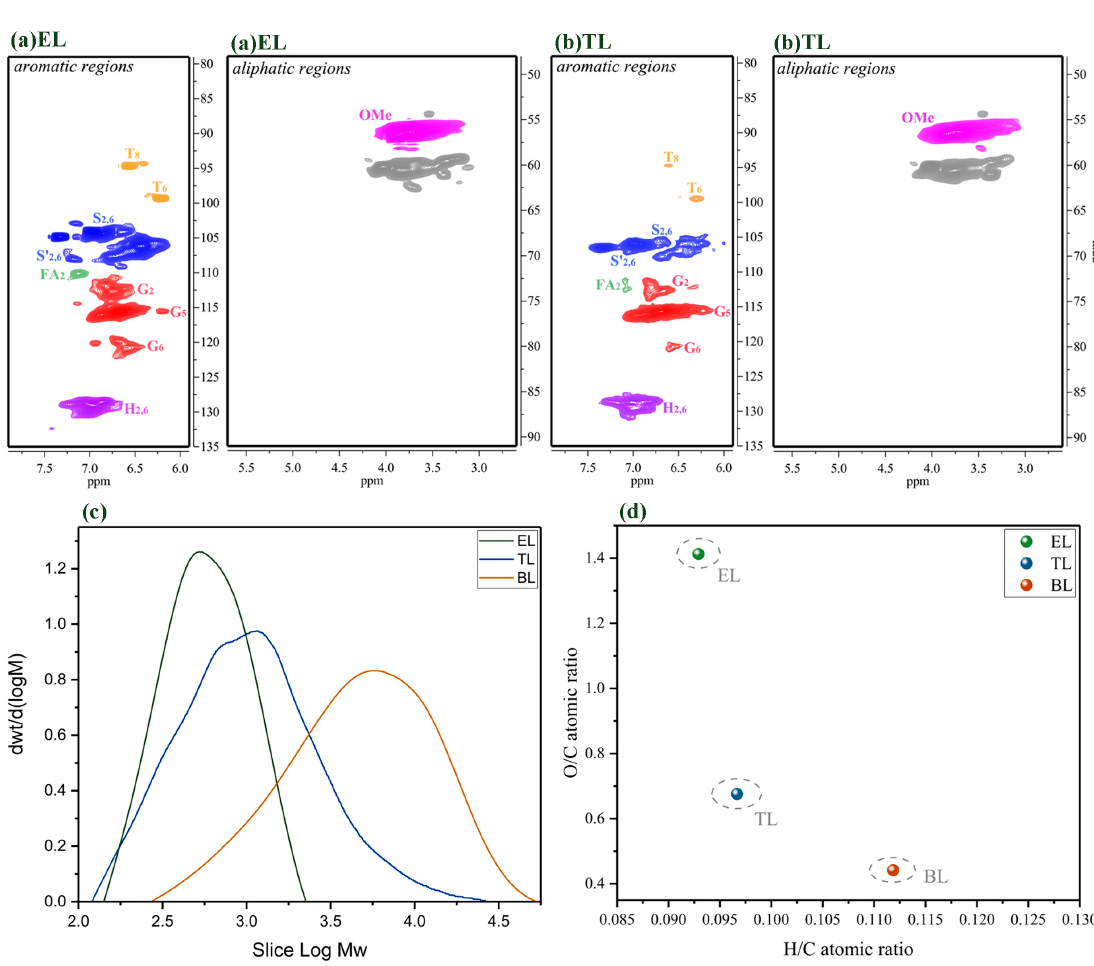
Figure 8. The 2D-HSQC NMR spectra, GPC, and elemental analysis of the residual lignin at 250 °C for 6 h. ( a ) The 2D-HSQC NMR spectra of the ethanol-soluble (EL) residue at 250 °C for 6 h; ( b ) the 2D-HSQC NMR spectra of the THF-soluble (TL) residue at 250 °C for 6 h; ( c ) the GPC of the EL and TL residues at 250 °C for 6 h; ( d ) elemental analysis of the EL and TL residues at 250 °C for 6 h.